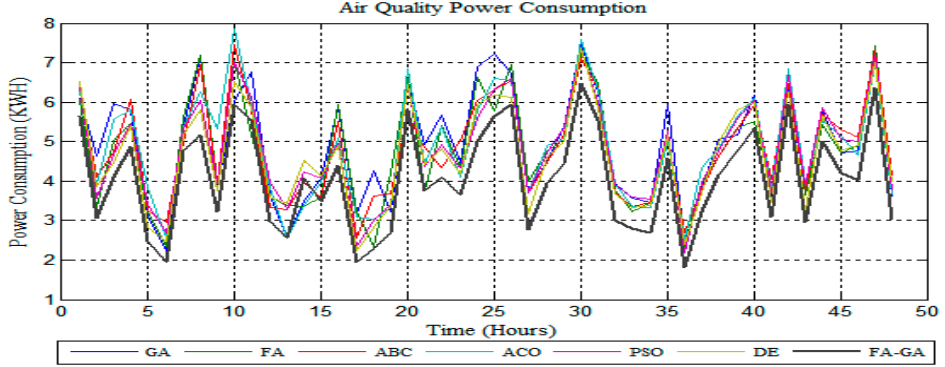
Figure 11. Power consumption for the air quality based on the considered approaches.